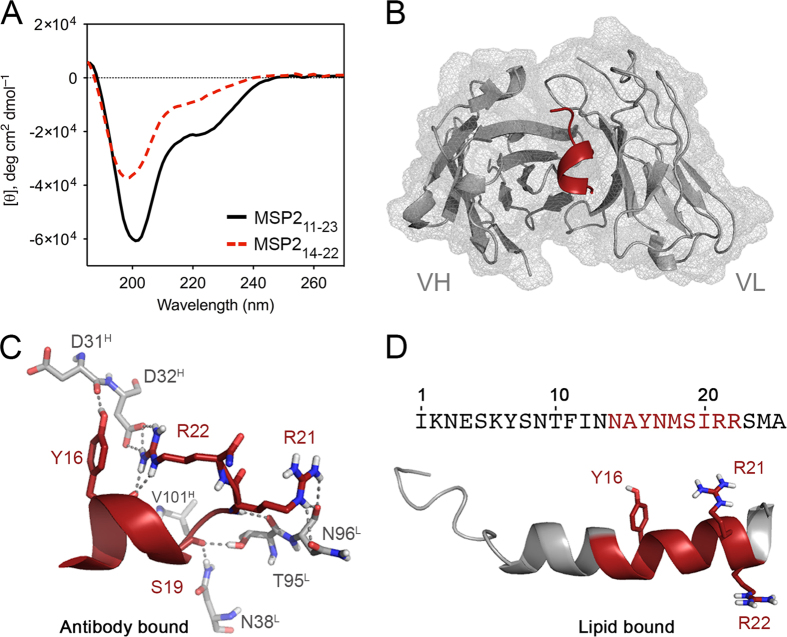
Crystal structure to 1.2 Å resolution of 6D8 Fv bound to the 9-mer peptide MSP214–22. (A) Helical propensity of synthetic epitope-bearing peptides MSP211–23 and MSP214–22. Both peptides showed ellipticity at 190, 208 and 220 nm, consistent with some helical content in water, with the longer peptide having significantly greater tendency for helical conformation. (B) Crystal structure of MSP214–22 at the paratope cleft formed by the antibody CDRs. (C) MSP214–22 adopts a single turn of helix stabilized by hydrogen bonds with residues Asp31H, Asp32H, Val101H and Asn38L. In solution, Arg22 contacts residues Thr91L and Asn92L while the guanidine group of Arg23 of the peptide bends towards the N-terminus of the peptide, establishing critical hydrogen bonds with Asp32 in the VH chain and the carbonyl of Tyr16. (D) The structure of the lipid-bound form of MSP21–2525 indicating the relative orientation of residues Try16, Arg21 and Arg22. The α-helical configuration of the lipid-bound MSP21–25 removes the backbone flexibility required for Arg22 to access Tyr16, which provides a structural rationale for the lack of binding of mAb 6D8 to MSP2 at the parasite membrane.